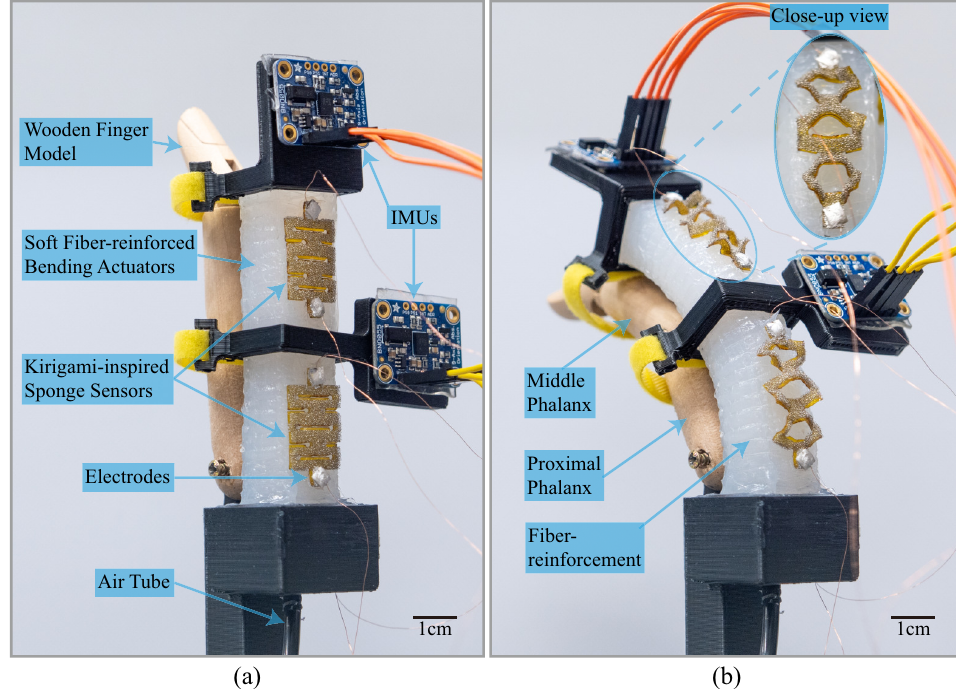
Figure 3. Experimental setup of bending angle perception of a soft pneumatic fiber-reinforced bending actuator by kirigami-inspired flexible sponge sensors. ( a ) The actuator is at resting state; ( b ) the actuator is at pressurized state. A scale bar of 1cm